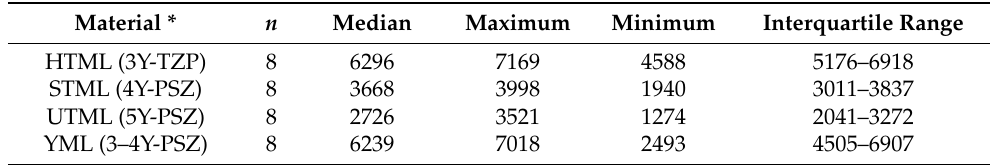
Figure 3. Fracture load results after artificial aging by chewing simulation, showing median, inter- quartile range (IQR, 75th percentile (Q1), 25th percentile (Q3)), upper whisker (Q1–1.5 IQR), lower whisker (Q3–1.5 IQR), and outliers. Table 1. Fracture load values (FL) in N after artificial aging by chewing simulation.